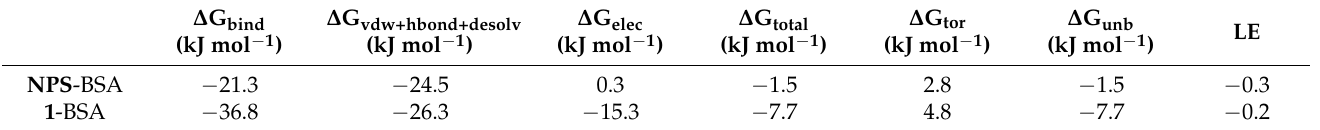
Figure 8. The hydrogen bond (green and orange dotted lines) and hydrophobic (rose pink dotted lines) docking interactions of the most stable conformations of NPS and 1 with BSA. Table 4. The important thermodynamic parameters for best docking conformations of investigated molecules with BSA (PDB ID: 4OR0).